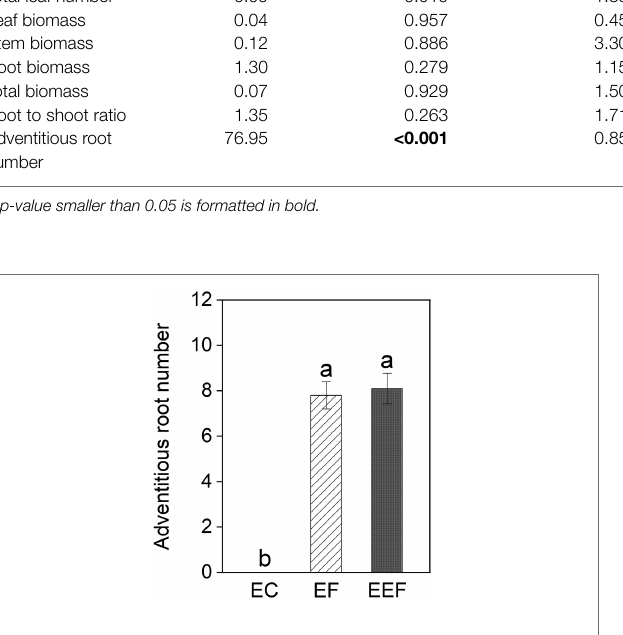
FIGURE 2 | Adventitious root number of P. hydropiper subjected to early control (EC), early flooding (EF), and early eutrophic flooding (EEF) at the end of early treatments. Different lowercase letters represent significant differences among the three early